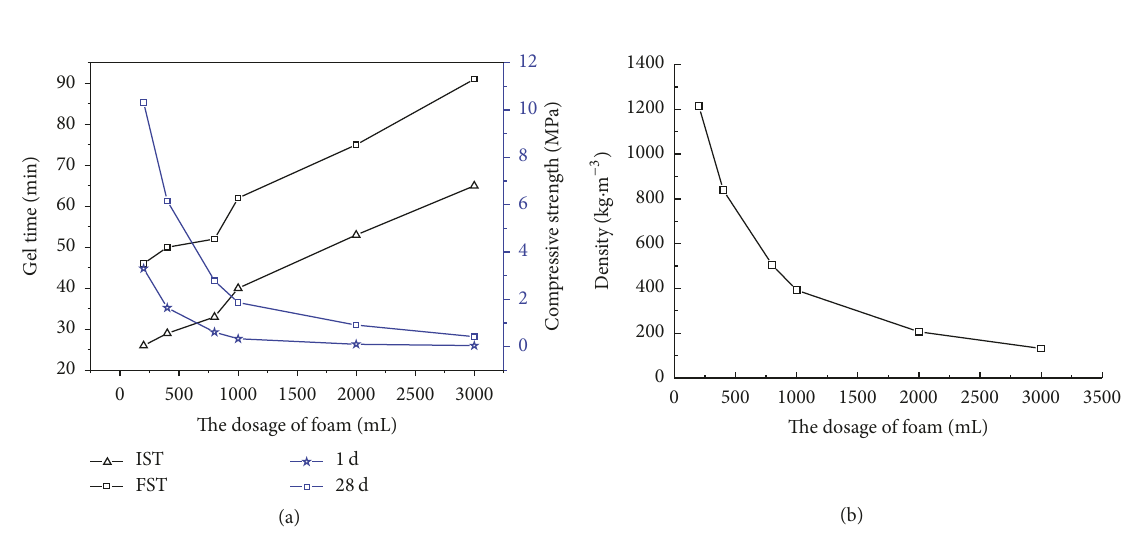
Figure 7: Effect of the dosage from foam on the